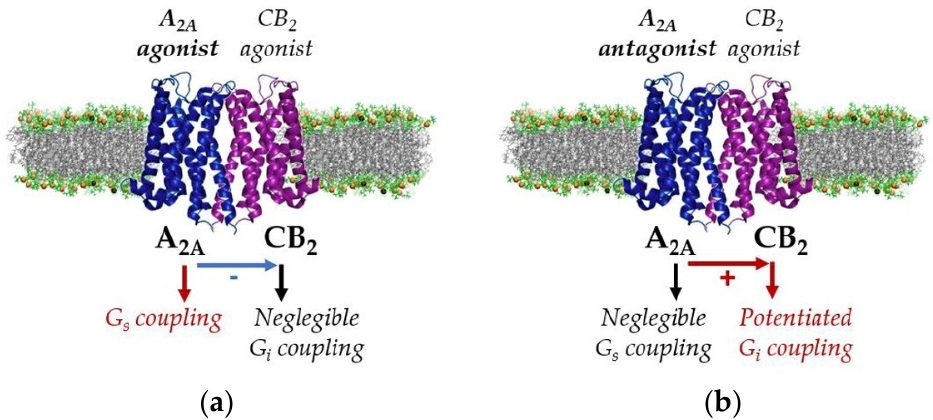
Figure 3. Schematic view of signaling processes driven by the A 2A –CB 2 receptor complex in microglia [94]. cAMP determination assays are consistent with G s coupling to A 2A and with G i coupling to CB 2 . ( a ) Upon simultaneous treatment using the two agonists, the G i coupling was negligible, indicating that A 2A activation blocks CB 2 -mediated signaling; ( b ) The administration of antagonists of the A 2A receptor (e.g., SCH58621) blocked the effect of the A 2A agonist and potentiated CB 2 receptor signaling in the A 2A –CB 2 heteromer context.